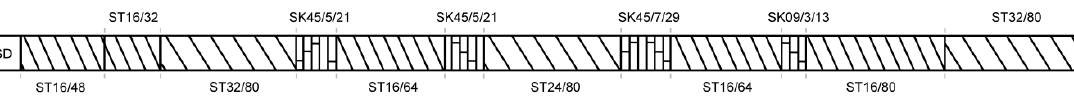
Figure 1. Screw configuration used in the study. The first number denotes the length of a single screw path, and the second number the length of a single segment. Table 2. Combinations of processing parameters.